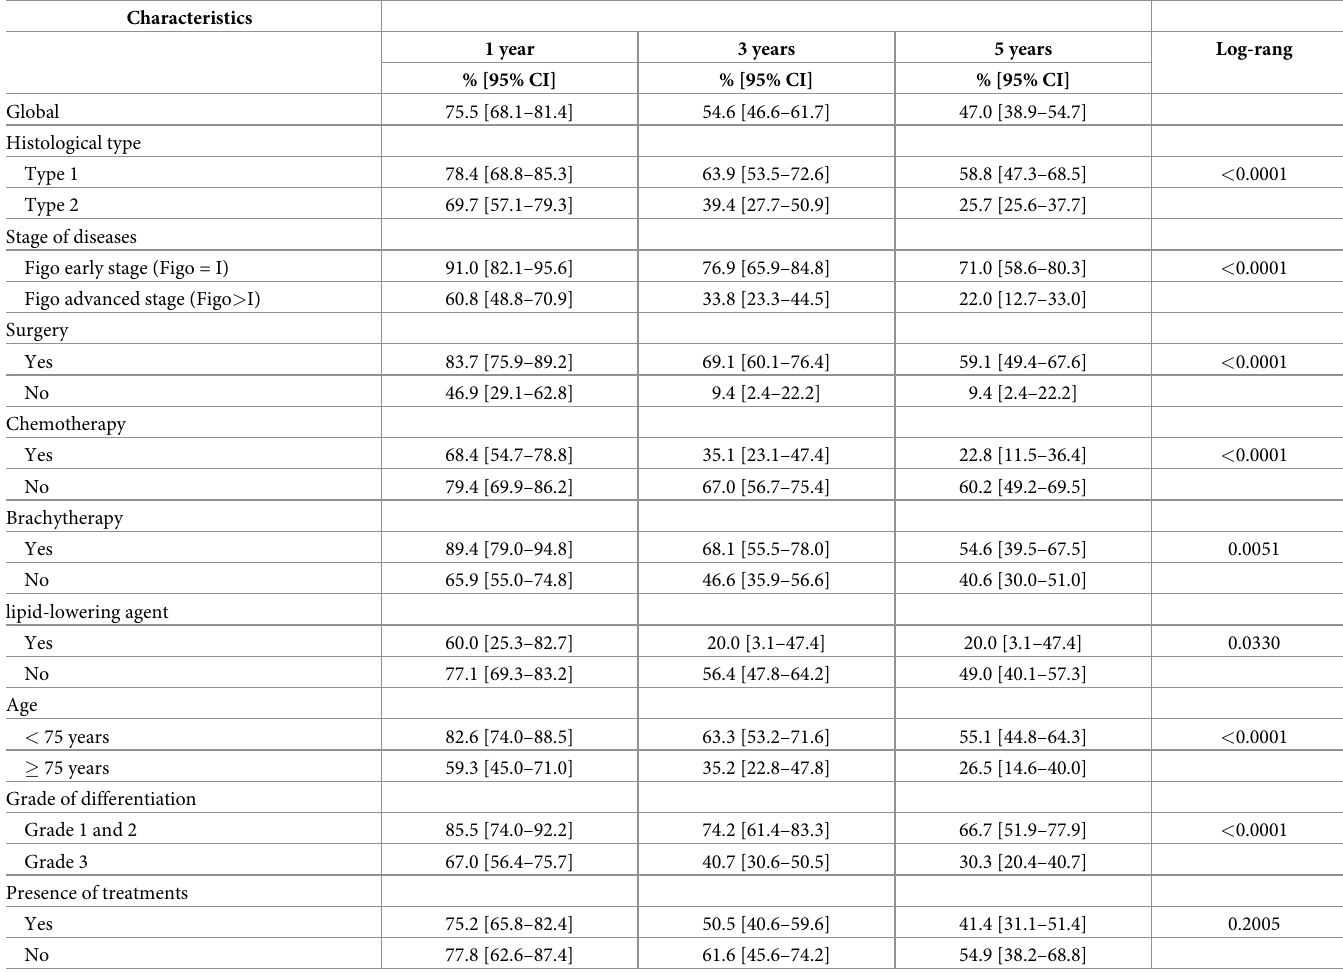
Table 4. Overall survival in endometrial cancer patients in